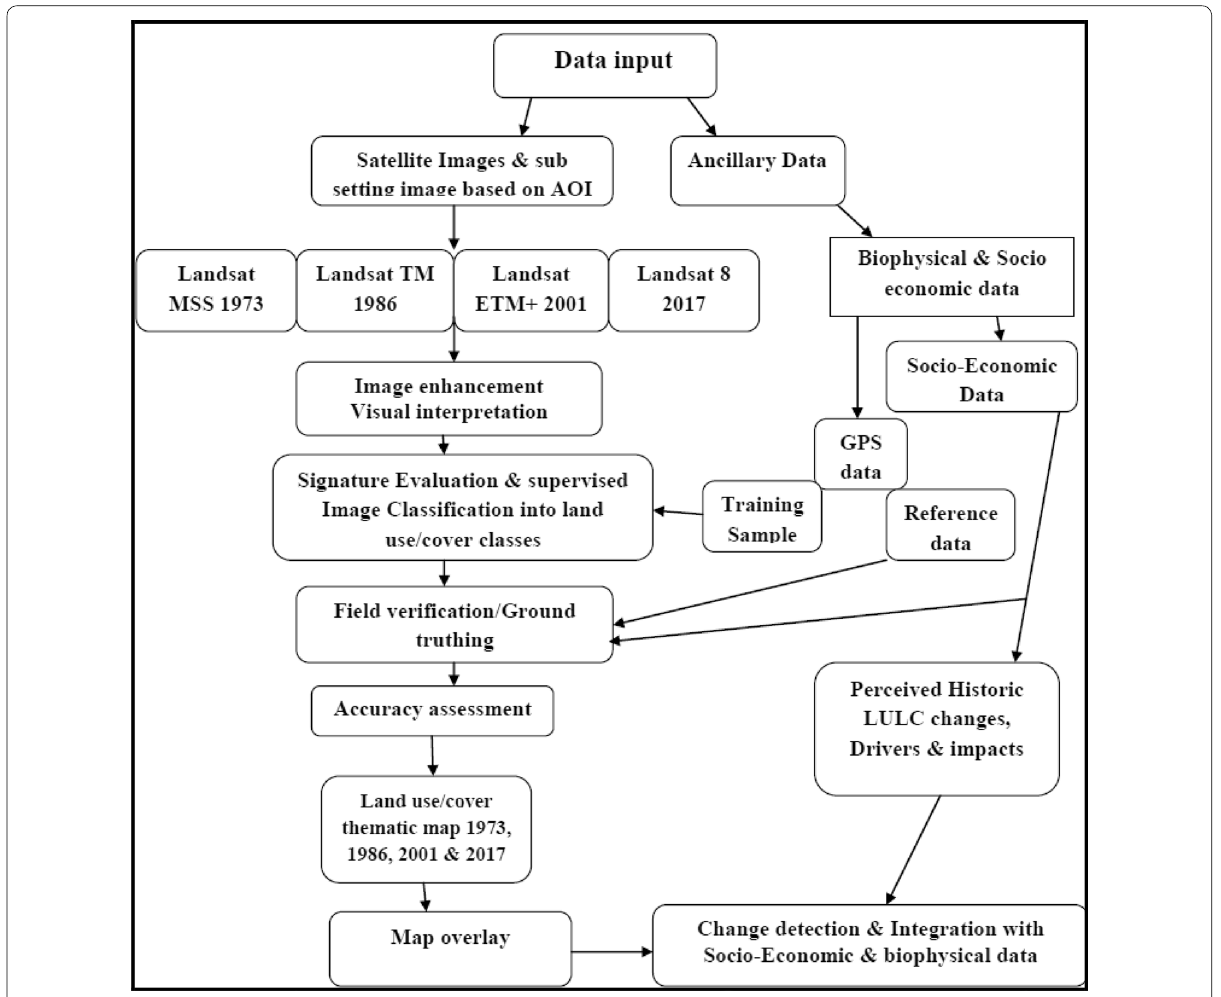
Fig. 6 Methodological flow chart showing the sequence of image classification and analysis